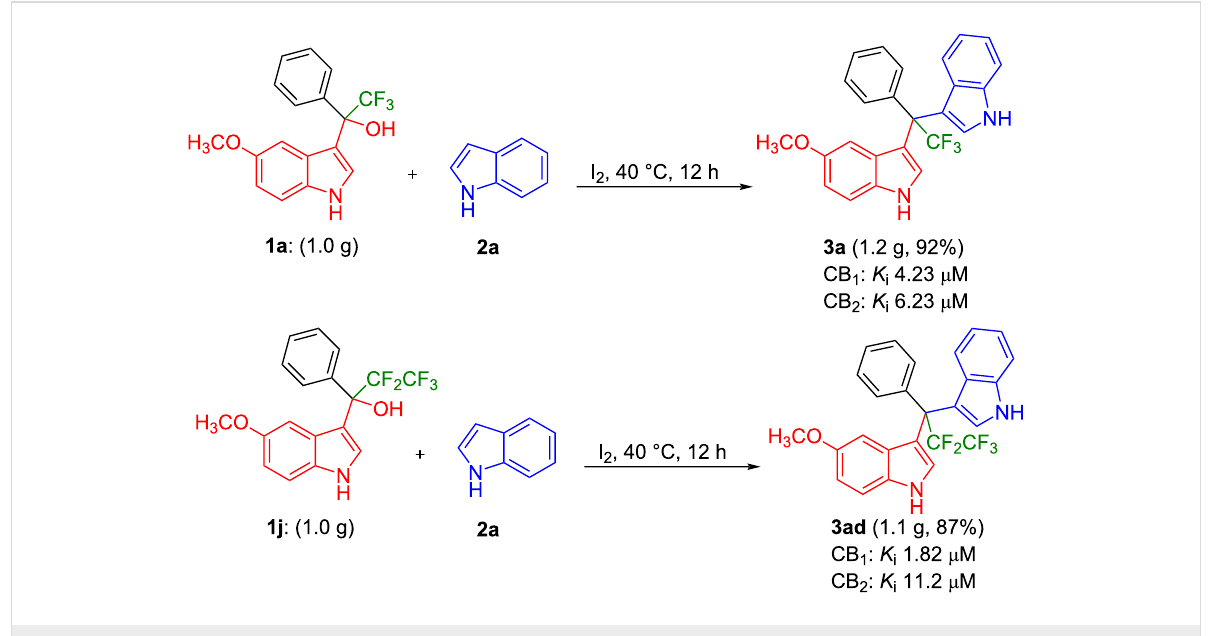
Figure 4: Gram-scale synthesis of unsymmetrical DIMs 3a and 3ad